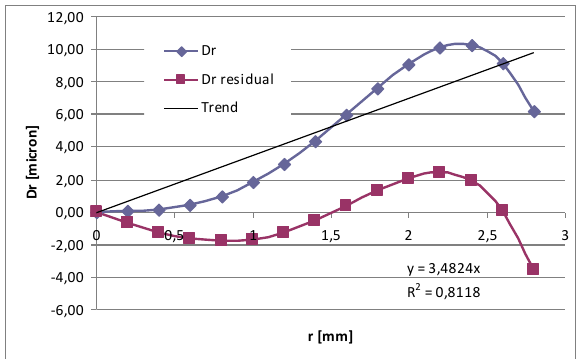
Figure 2. Results of radial lens distortions of Samsung